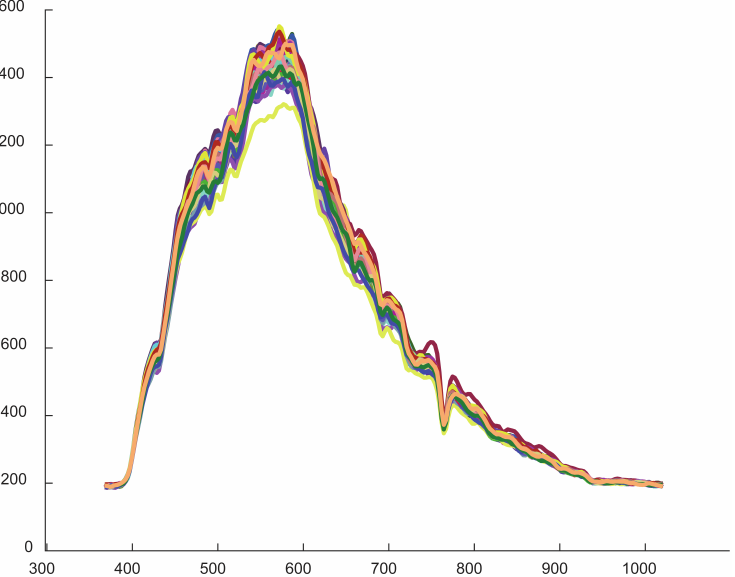
Figure 2. Examples of paint spectral of YU dataset acquired in an outdoor environment. This shows how difficult it is to classify spectral